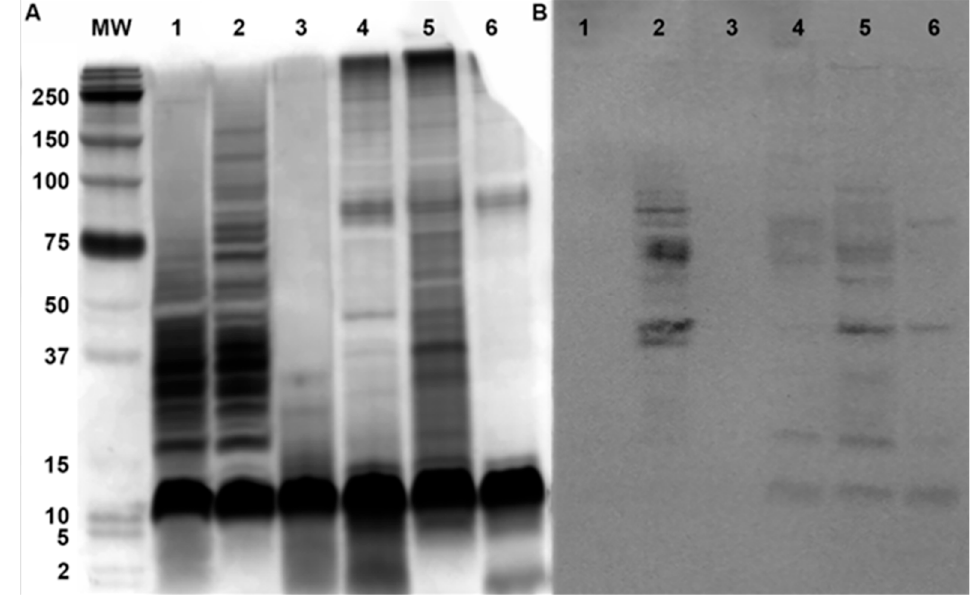
Figure 4. Susceptibility of proteins to enzymatic digestion. The panels represent: ( A ) SDS–PAGE and ( B ) Western Blot of duplicate gel. The lanes represent: MW, molecular weight standard (numbers on left in kD); 1, whole cell lysate (WCE) treated with trypsin for 24 h; 2, WCE untreated; 3, WCE treated with proteinase K for 24 h; 4, SVs treated with trypsin for 24 h; 5, SVs untreated; 6, SVs treated with proteinase K.